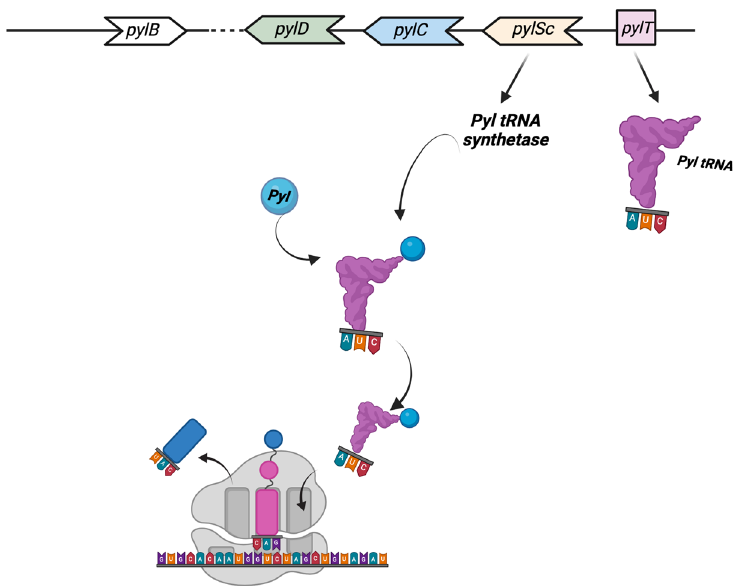
Figure 3. The Pyl insertion system. Pyl, synthesized by pylB , pylD , pylC , is charged on a specific tRNA (encoded by pylT ) whose anticodon AUC recognizes UAG codons. See text for details. This figure was created with BioRender.com (accessed on 7 December 2022).